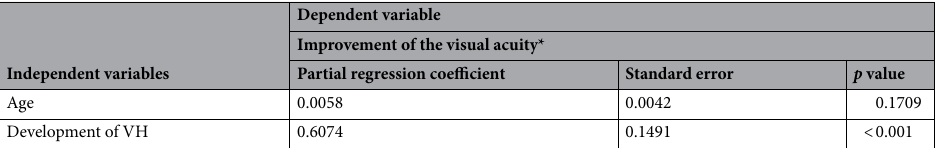
Table 3. Stepwise multiple regression analysis of the improvement of the BCVA. Excluded variables: sex, type of anti-VEGF agents, taking anticoaglants, subtype of AMD, duration of symptoms, DAs, baseline BCVA, CFT, thickness of SMH, and thickness of PED. BCVA best-corrected visual acuity, VH vitreous hemorrhage, VEGF vascular endothelial growth factor, AMD age-related macualr degeneration, DAs disc areas, CFT central foveal thickness, SMH submacular hemorrhage, PED pigment epithelial detachment. *Improvement of the visual acuity = the difference between the baseline visual acuity and postinjection BCVA at 12 months.